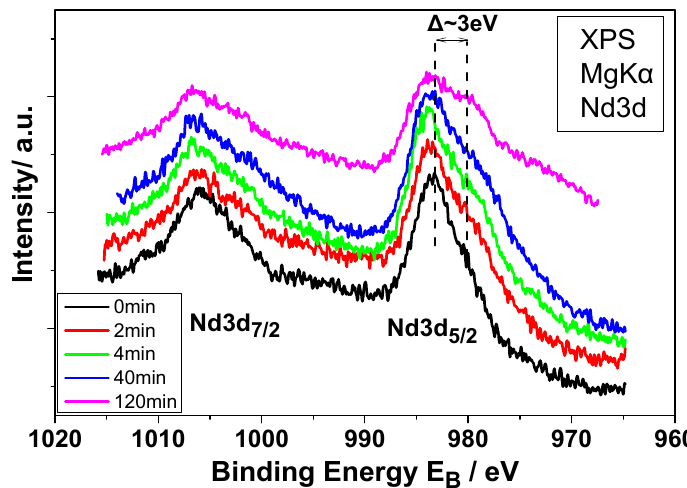
Figure 10. X-ray Photoelectron Spectroscopy (XPS) core level spectra of Nd3d of the electrodeposit after introduction in UHV before and after Ar + sputtering for 2 min, 4 min, 40 min, and 120 min.